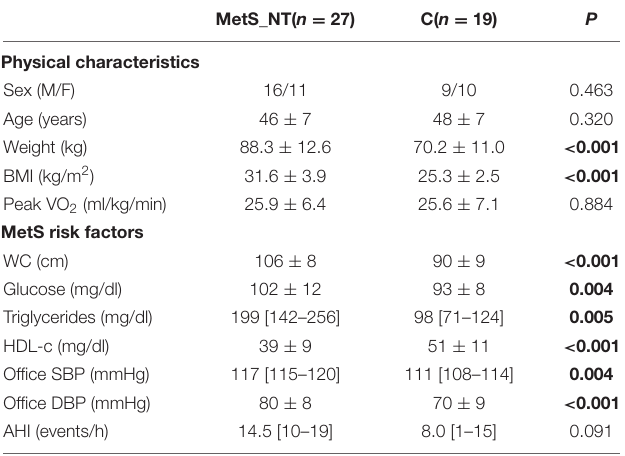
TABLE 1 | Physical characteristics, metabolic syndrome (MetS) risk factors, and polysomnography measurements in normotensive metabolic syndrome patients (MetS_NT) and in control (C) group.